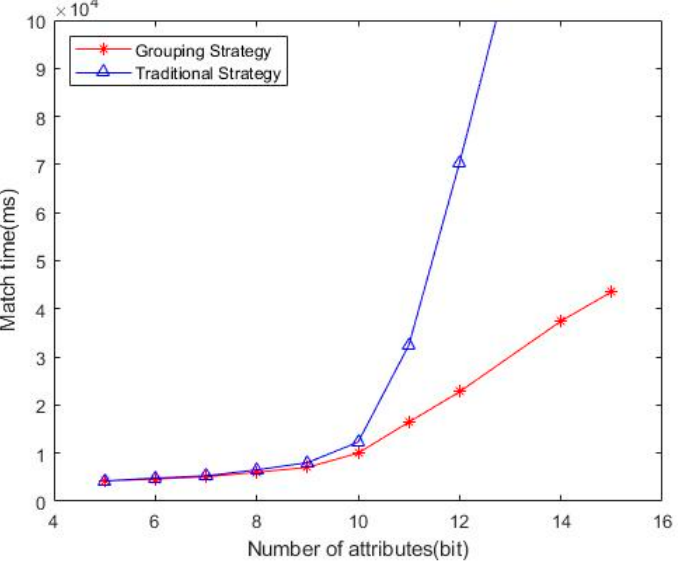
Figure 8. Strategy matching time comparison.